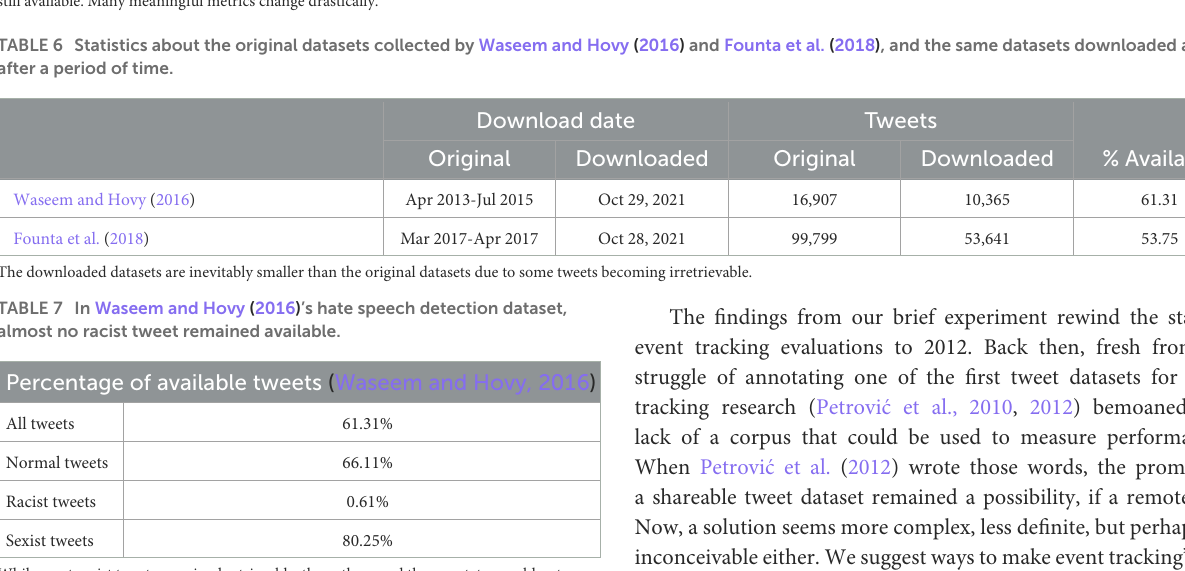
Percentage of available tweets